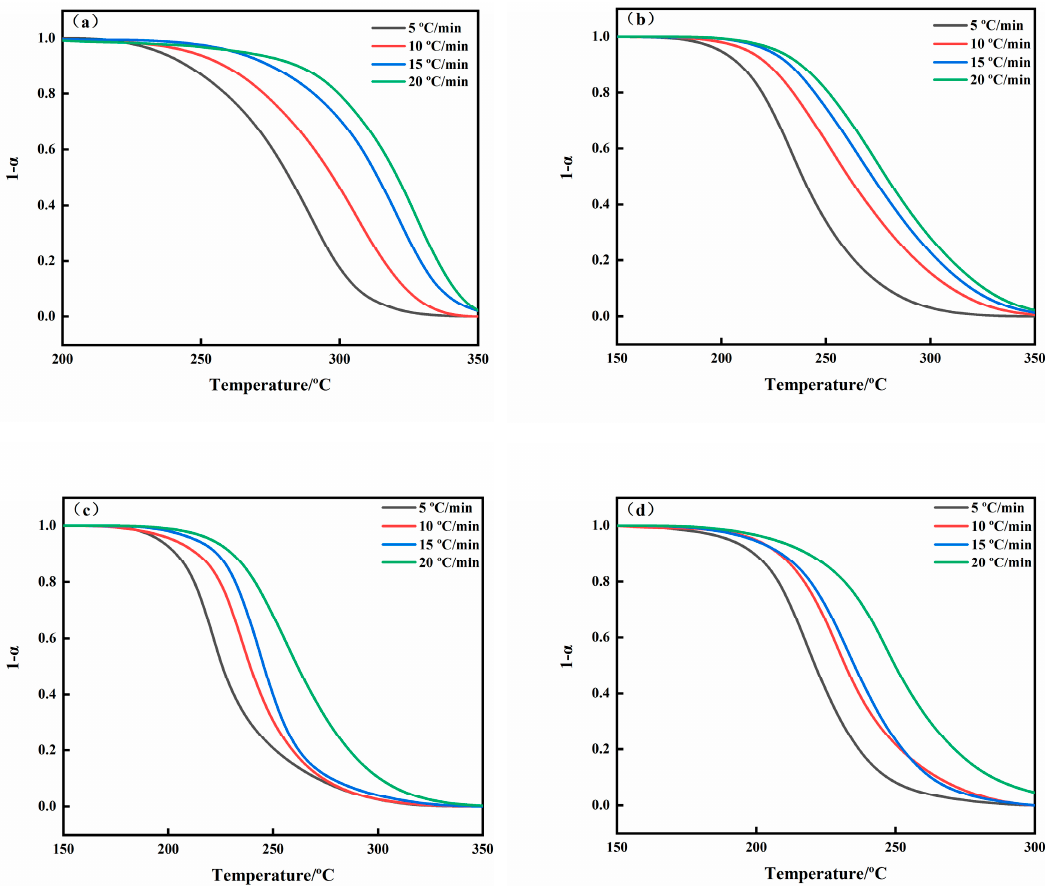
Figure 9. Degree of cure at different heating rates in the neat ( a ), 4 ( b ), 8 ( c ), and 10 wt% ( d ) systems.